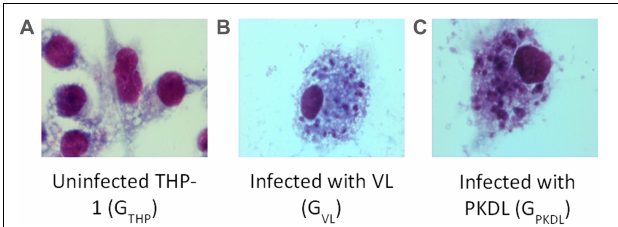
FIGURE 1 | Intracellular Leishmania donovani amastigotes visualized by stain. (A) Uninfected control THP cell. (B) THP cell infected with visceral leishmaniasis (VL) strain (G VL ). (C) THP cell infected with post-kala-azar dermal leishmaniasis (PKDL) strain (G PKDL ). G VL and G PKDL showed 60–70% infection rate. Optical microscopy at 100 × oil